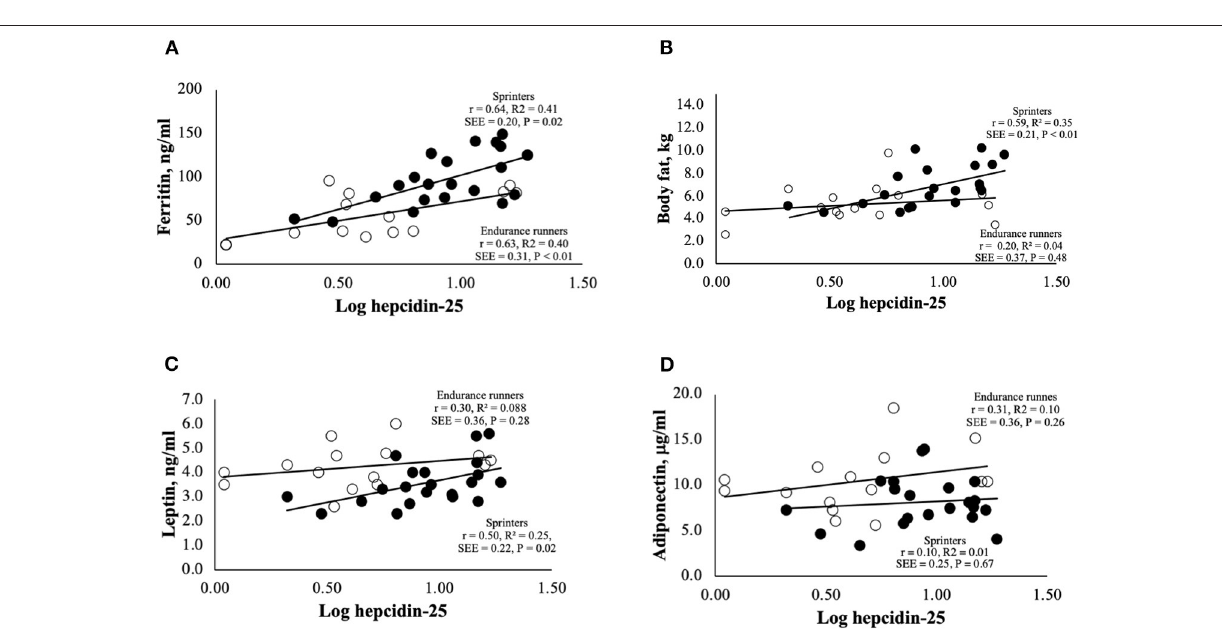
FIGURE 2 | Correlations between serum levels of hepcidin-25 and (A) ferritin, (B) body fat, (C) leptin, and (D) adiponectin for endurance runners and sprinters. The hepcidin-25 value was log transformed, to keep normal distribution. Correlations were determined using Pearson’s correlation coefficient. The open and closed circles represent the endurance runners and sprinters, respectively. SSE, Standard error of